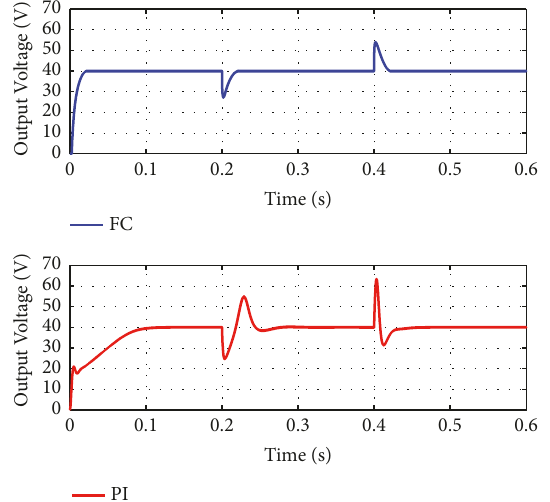
Figure 3: The response curves for output voltage under two control algorithms in the presence of load variations: finite-time control (FC) and PI